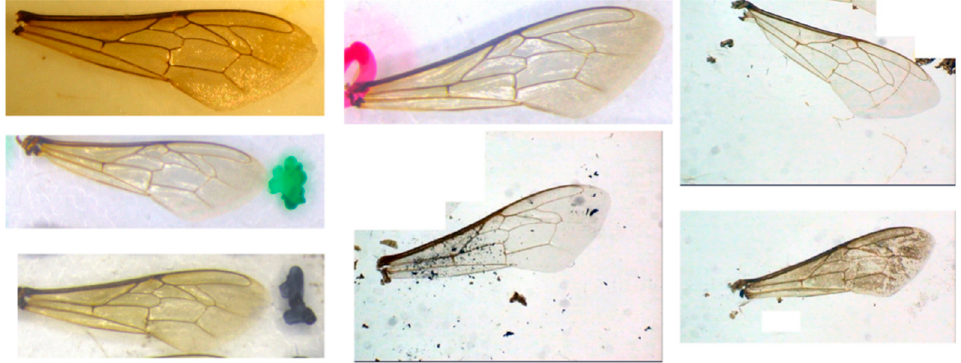
Figure 3. A sample of honey bee forewings showing the range of image quality.